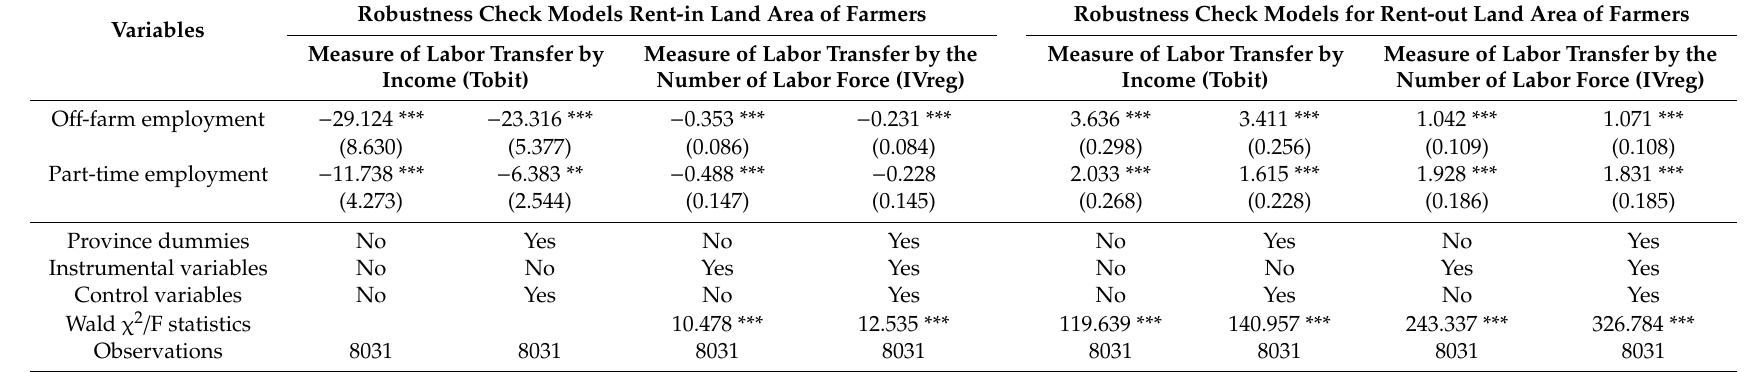
Table 5. Robustness check models estimation results of land transfer scale of